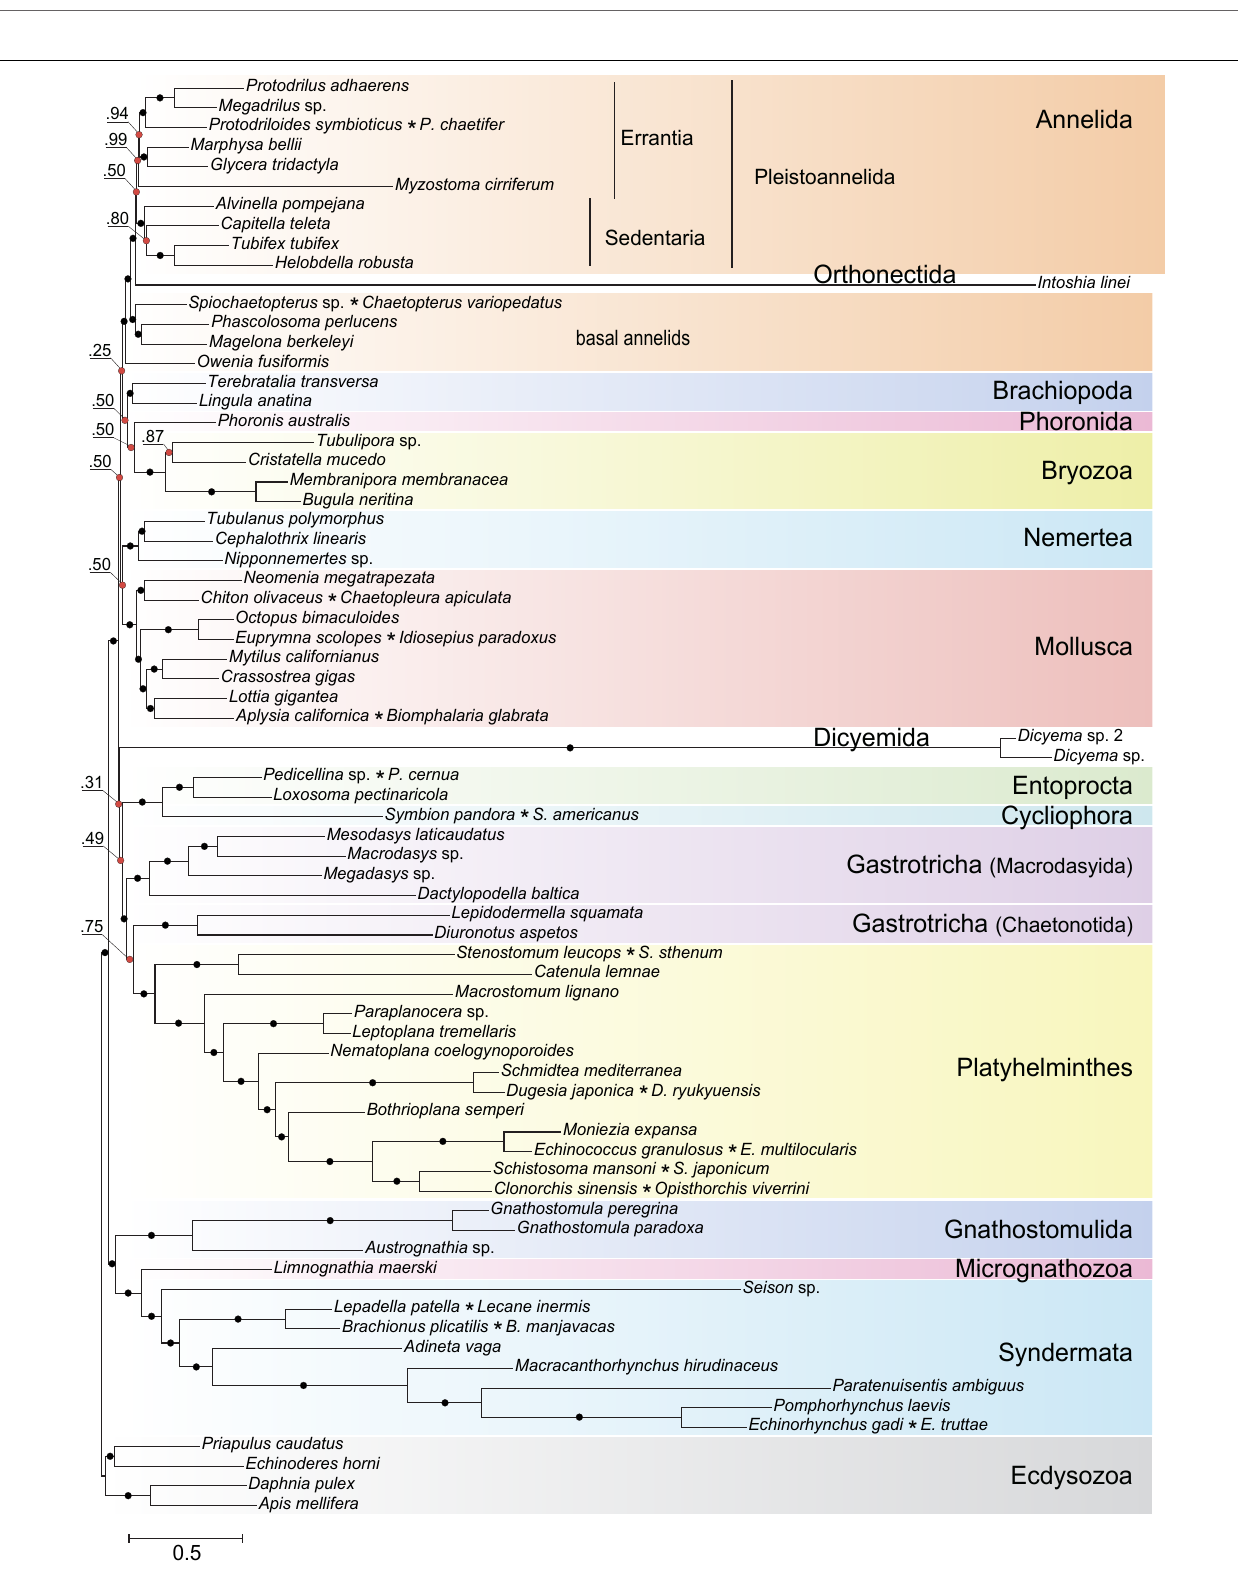
Frontiers in Genetics |